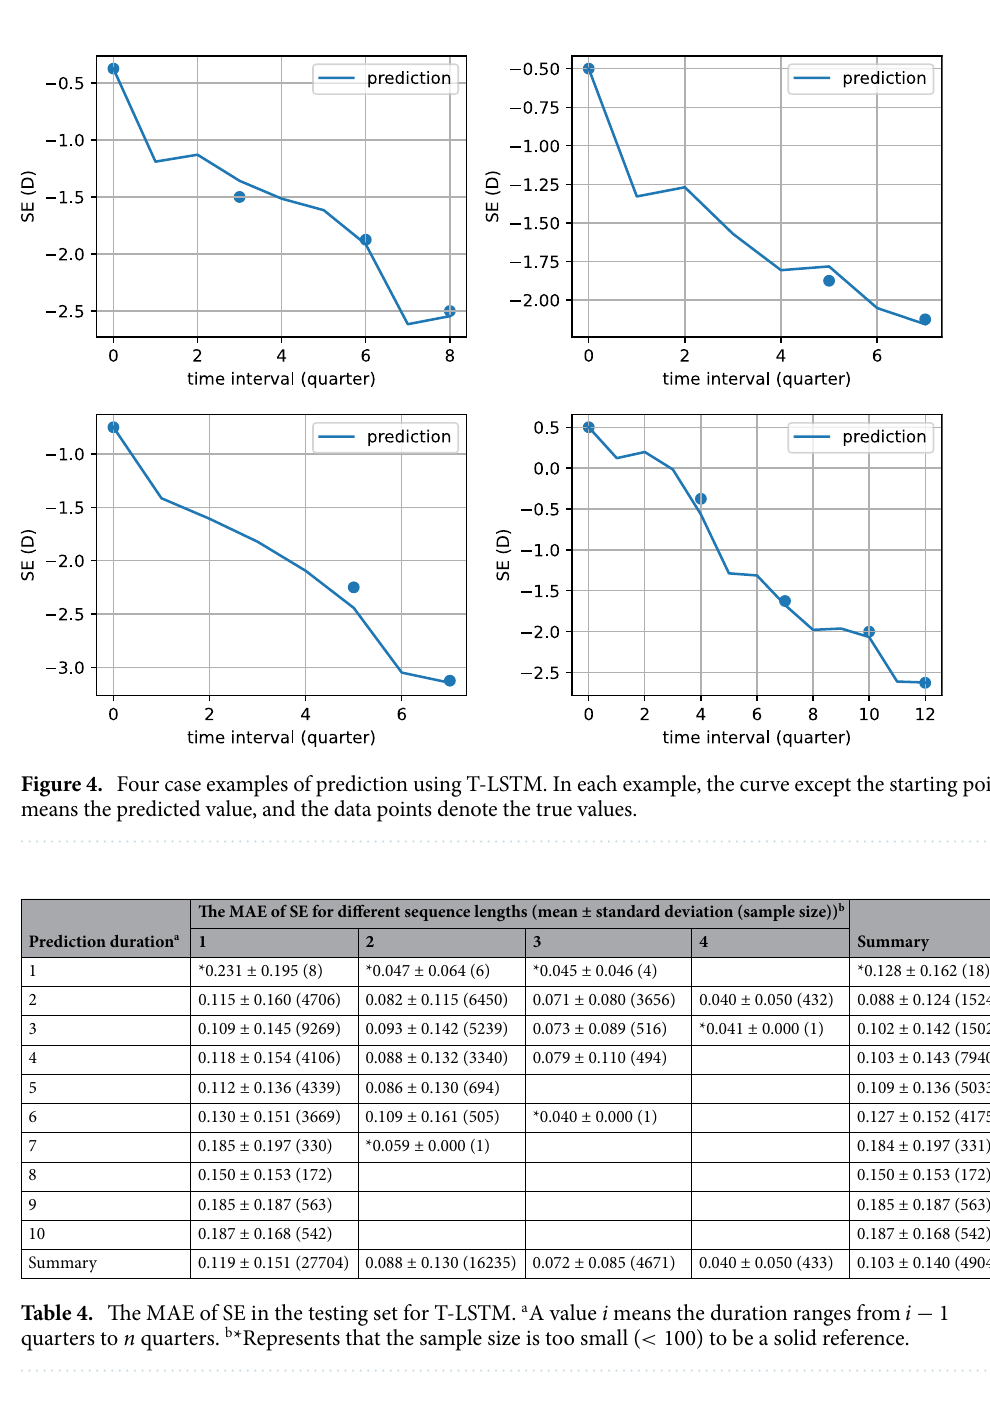
The MAE of SE for different sequence lengths (mean ± standard deviation) Model Summary1